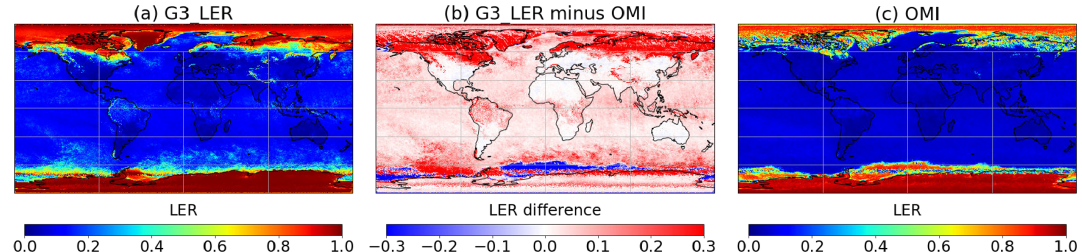
Figure 9. (a) TROPOMI G3_LER daily map (325–335nm) for 30 April 2018, (c) OMI LER climatology (335nm) for the month of April, and (b) the difference between these two datasets. There is very good agreement over land and water surfaces, with major differences in snow/ice regions of the OMI LER climatology from 2004 to 2007 that do not match with actual surface conditions observed in April 2018.